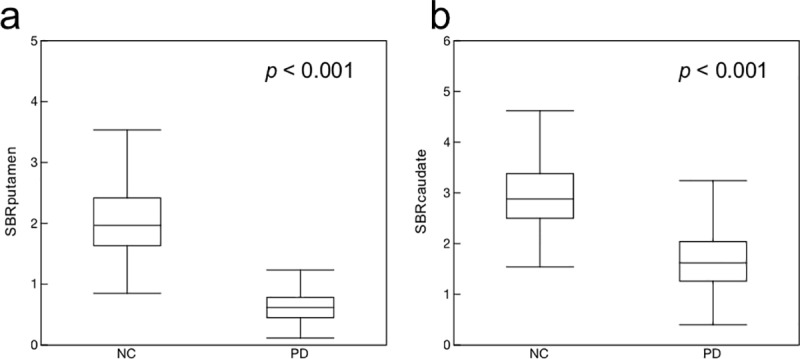
Comparisons of striatum binding ratios between normal control (NC) and Parkinson’s disease (PD) groups.(a) SBRputamen, (b) SBRcaudate.